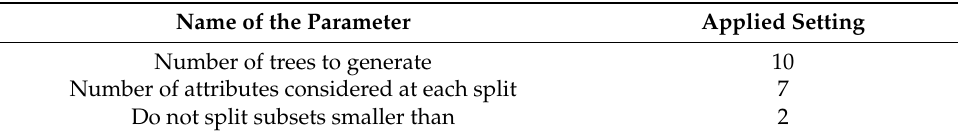
Table 6. Applied parameters for the random forest generation.